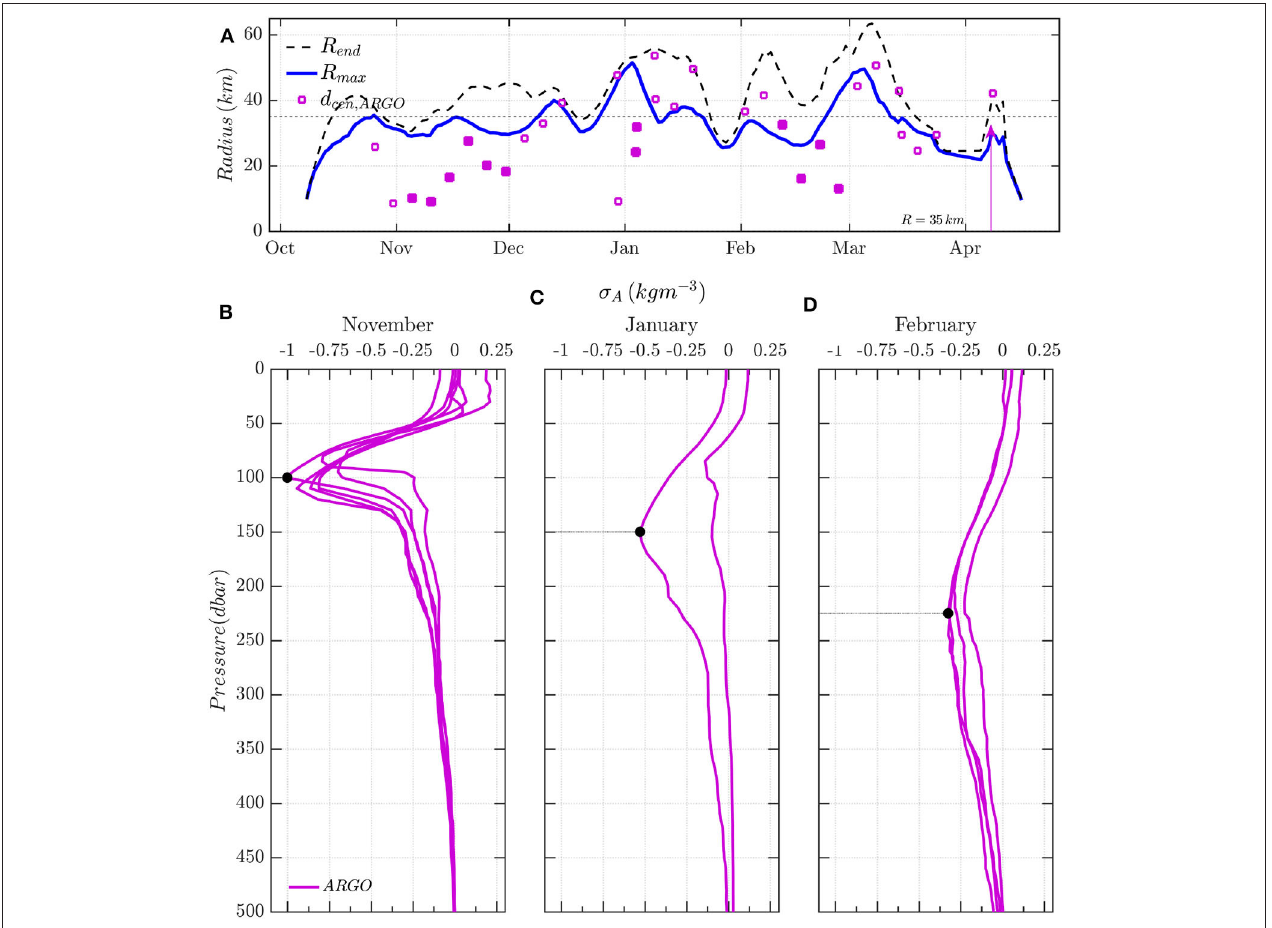
FIGURE 7 | (A) Temporal evolution of the O_IE15 eddy characteristic contour (blue line) and the last contour (black dashed line) as extracted from the DYNED-Atlas eddy database. The squared points illustrate the position of the Argo profiles as a function of their distance from the eddy center. Vertical profiles of density anomaly σ A ( kgm − 3 ) are shown for the months of (B) November 2015, (C) January 2016, and (D) February 2016 as obtained from the Argo float profiles that were trapped in the